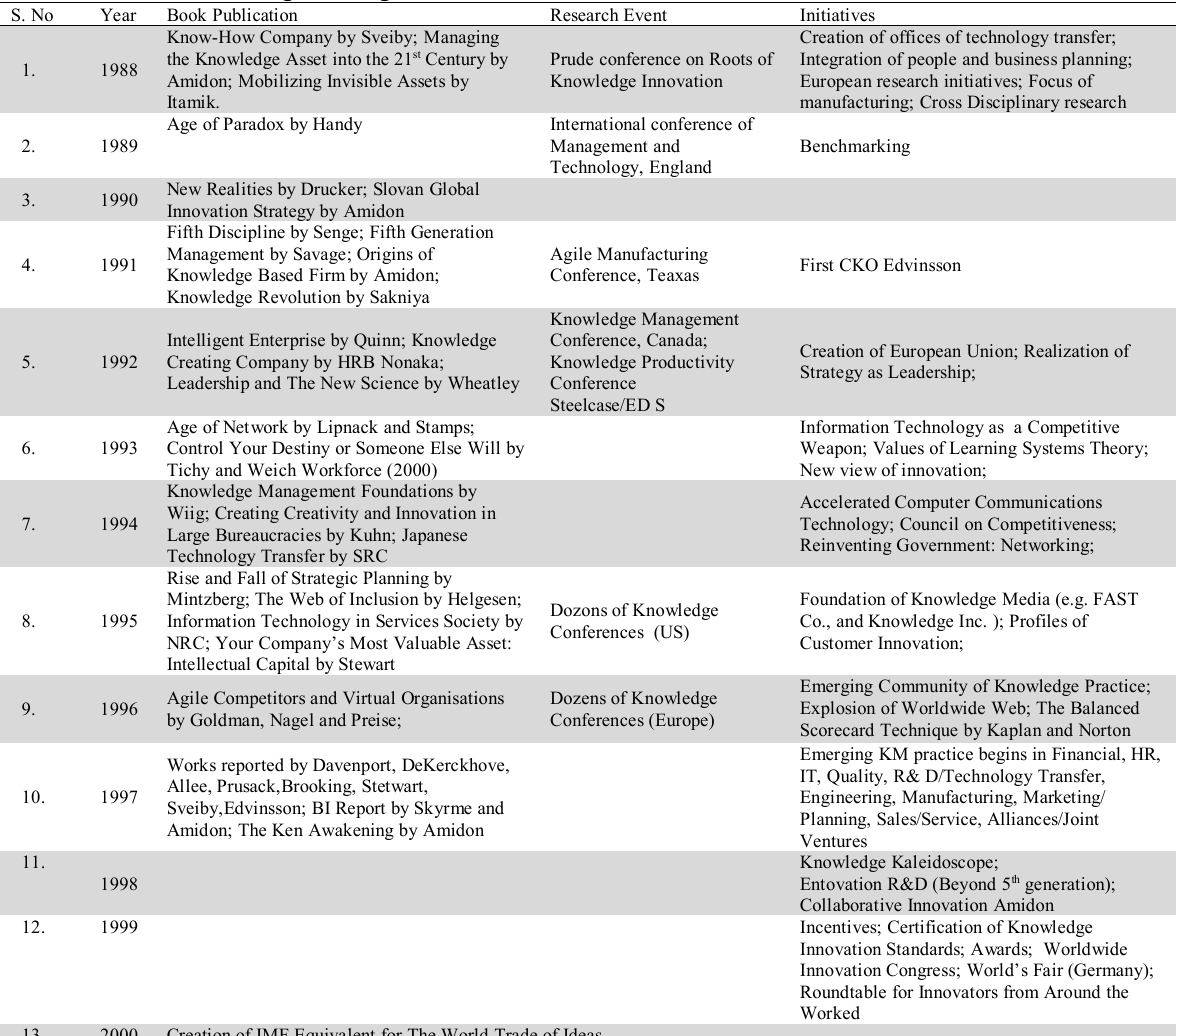
A Timeline of Knowledge